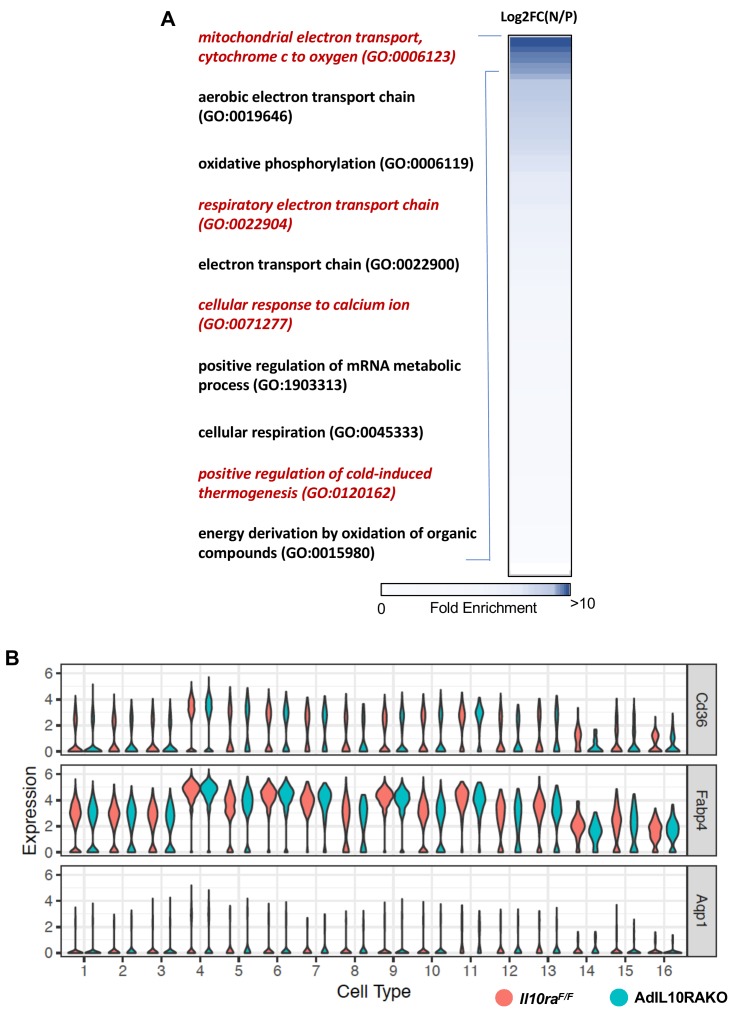
Thermogenic pathway is enriched in the Type 9 cluster of IL10Rα-deficient adipocytes.(A) Heatmap showing fold enrichment of pathways abundant in the adipocytes of AdIL10Rα KO mice compared to controls. DEG analysis of N represent Adipq-CRE Negative IL10RαF/F (IL10RαF/F) and P represent Adipoq-Cre Positive (AdIL10Rα KO) mice was performed and fold-change was calculated as Log2FC(N/P) and gene ontology analysis was performed for genes enriched in P over N and plotted as a heatmap as fold-enrichment (0 to >10) and p<0.001. Shades of blue indicate highly enriched pathway in P with fold-enrichment >10. (B) Violin plot showing expression levels of indicated genes in iWAT adipocytes of AdIL10Rα KO mice and controls from SNAP-seq data (Figure 4).